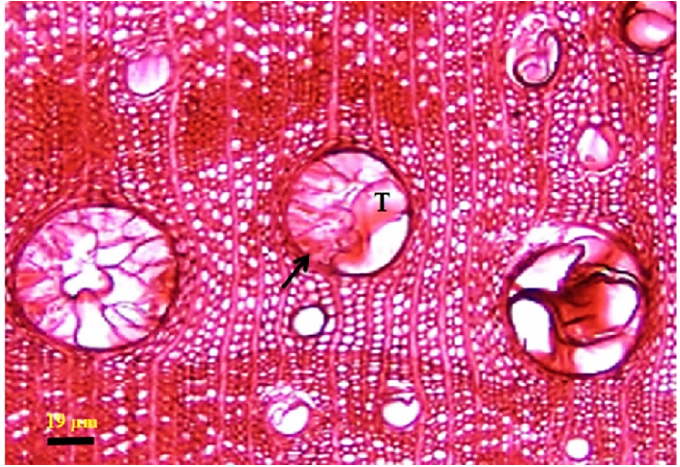
Figure 8. Tyloses (T) occluding vessel lumen in transverse section of a declined tree from near- bark tissues.